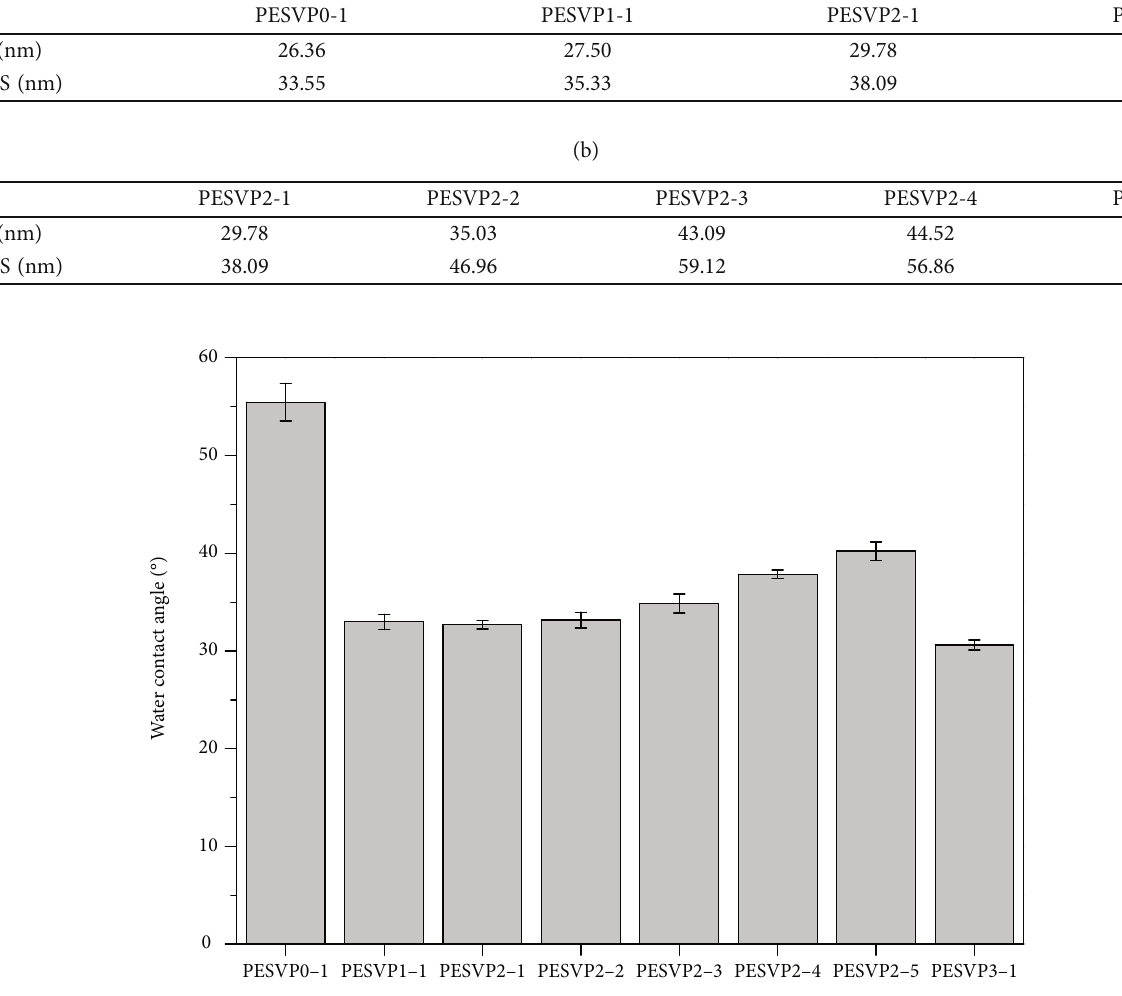
Figure 7: Water contact angle results of PESVP